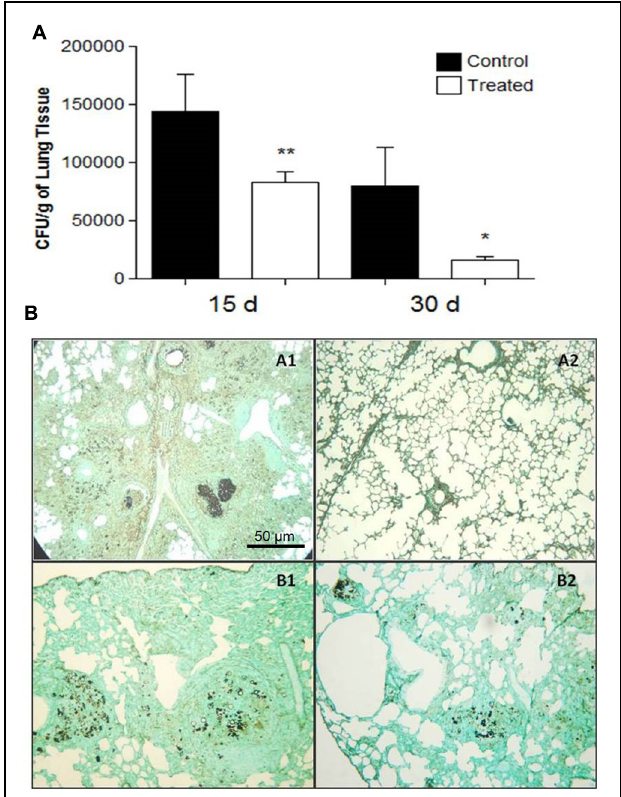
FIGURE 3 | (A) Colony forming units (CFU) in the lungs from BALB/c mice that received 1 mg of polyclonal antibodies against acidic glycolipids and 1 mg anti-BSA polyclonal antibodies (control) 24 h before infection with Pb18 and sacrificed after 15 and 30 days (prophylactic protocol). Significant values comparing the lungs of treated and control groups. ∗ p < 0.05, ∗∗ p < 0.01. (B) Representative lung sections: Prophylactic protocol. 24 h prior to infection, mice received polyclonal antibodies to acidic GSLs. Histopathological sections of murine lungs 15 (A1, A2) and 30 (B1, B2) days after i.t. infection. (A1, B1) Lungs from control mice; (A2, B2) Histopathological sections after i.t. infection. Photographs of sections were taken at 100 × magnification.